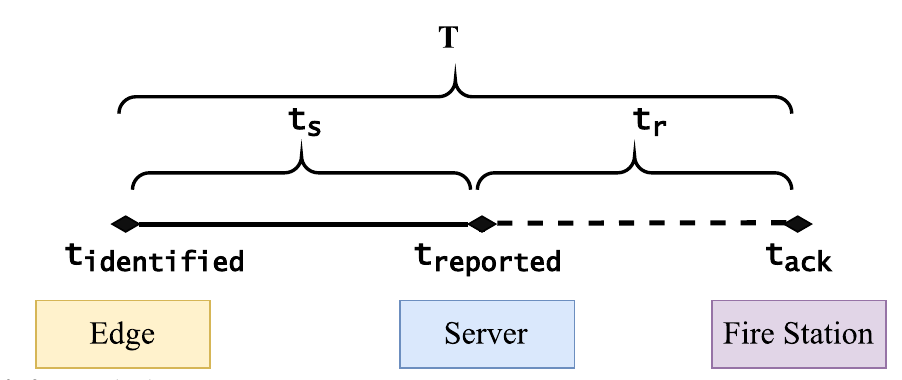
Fig. 8 Timeline for fire event